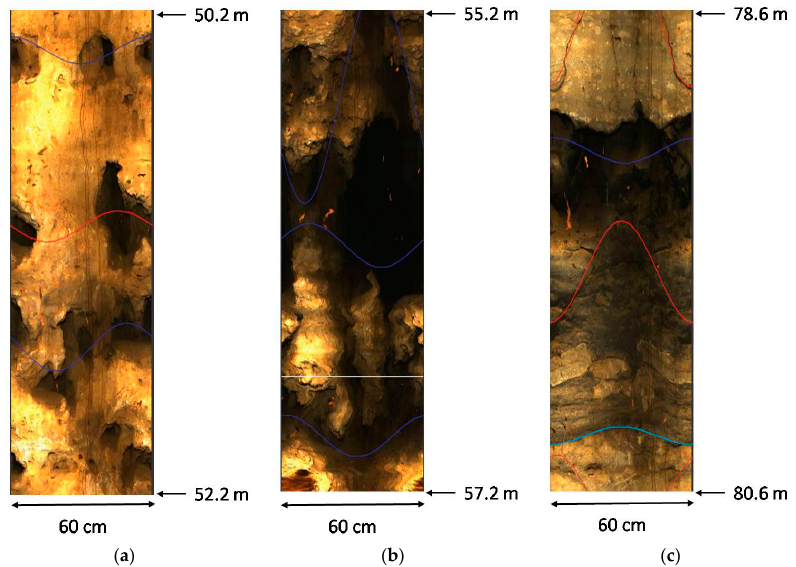
Figure 19. BHTV optic images at well MP7 ( a ) at depth 51 m, ( b ) at depth 56 m, ( c ) at depth 80 m.